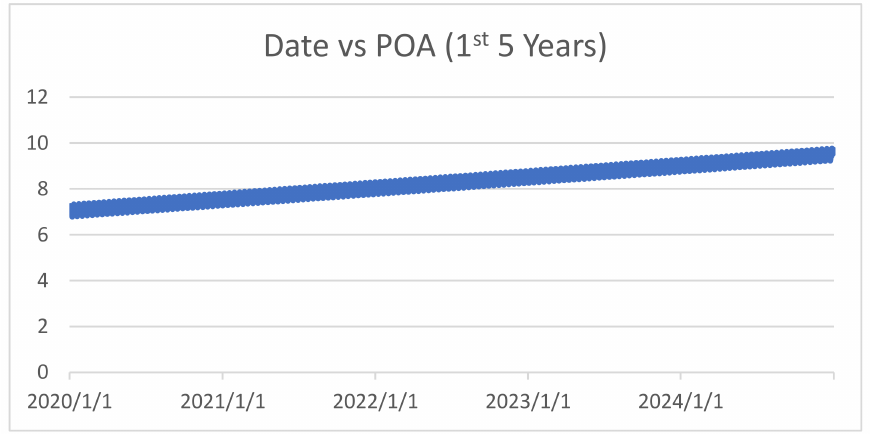
Figure 11. First 5 years’ prediction results of the plane of array (POA) from 1 January 2020 to 1 January